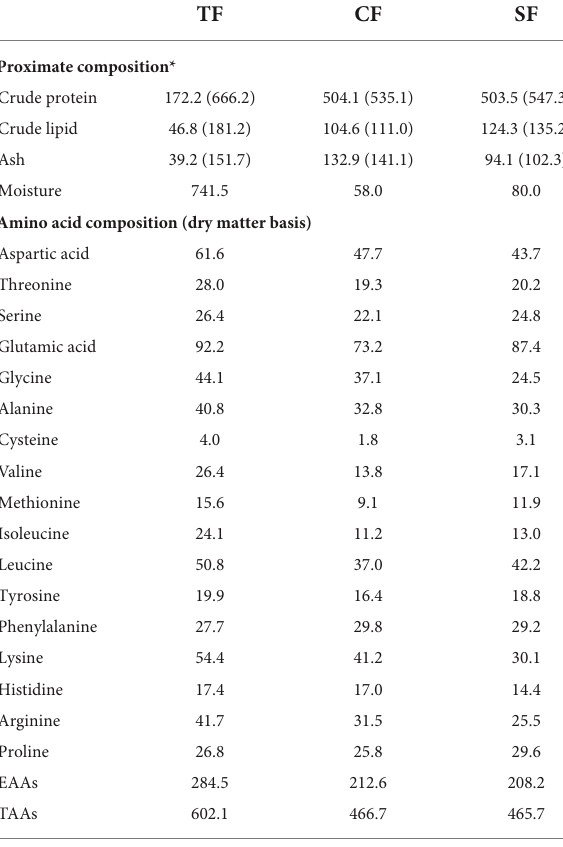
TABLE 1 Proximate composition and amino acid composition of the experimental diets (g/kg).